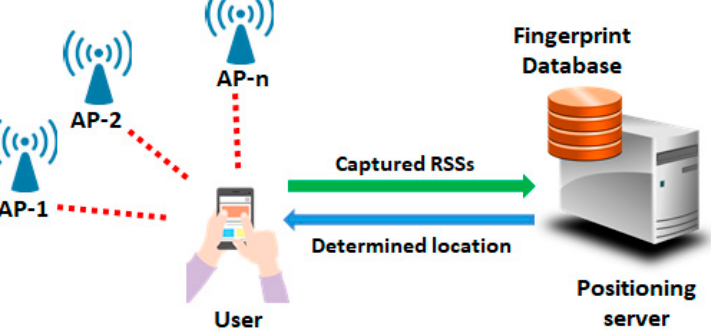
Figure 1. Illustration of Wi-Fi fingerprint-based indoor positioning system.